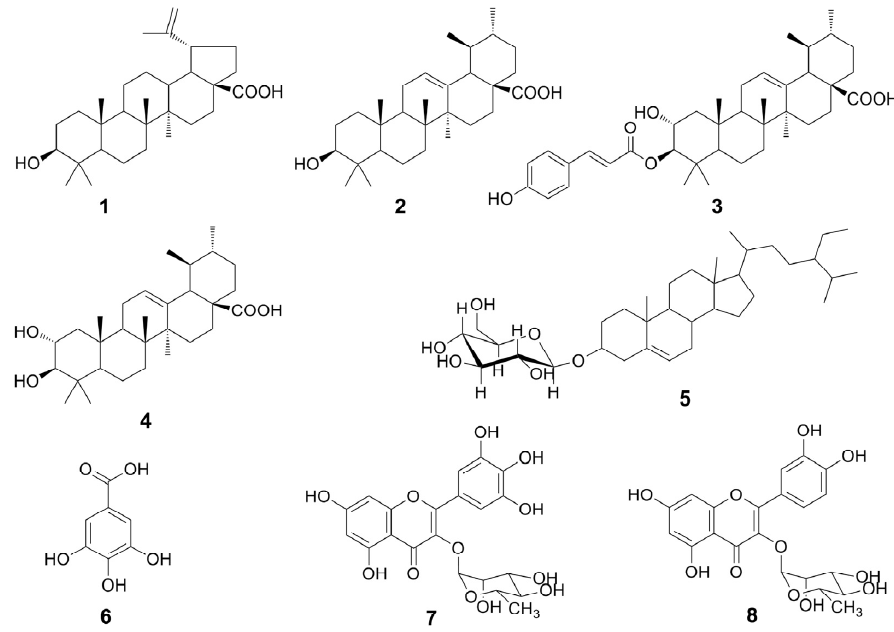
Figure 1. Isolated compounds from S. antisepticum young leaves. The isolated compounds 1 – 8 were evaluated for acetylcholinesterase inhibitory and DPPH scavenging activities. The results showed that among those of compounds isolated from S. antisepticum leaves, ursolic acid ( 2 ) and gallic acid ( 6 ) exhibited anticholinesterase activity with more than inhibitory effect of 50% at a concentration of 100 µg/mL and had the IC 50 values of 159.32 ± 1.34 µM and 161.06 ± 9.52 µM, respectively (Table 1). This result